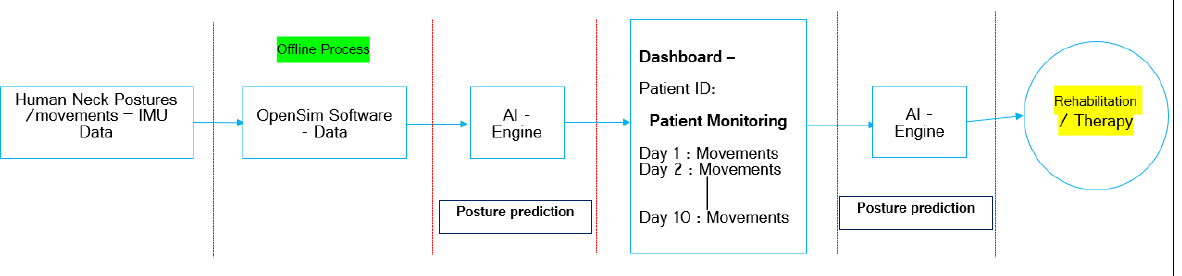
Figure 13. Research flow.